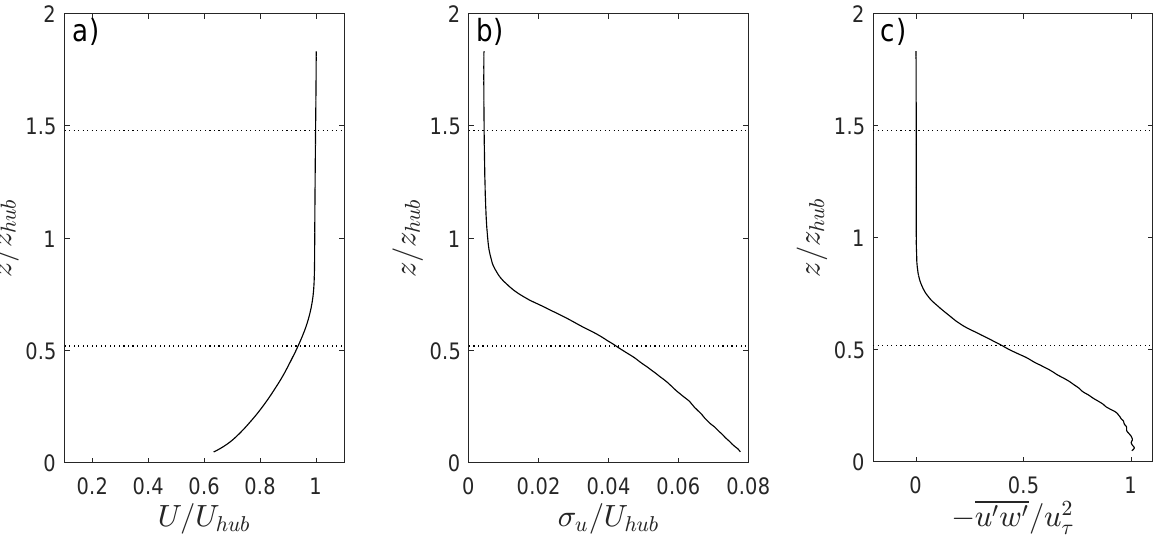
Figure 3. Non-dimensional characteristics of the incoming boundary layer. ( a ) mean velocity profile U/U ; ( b ) turbulence intensity σ hub Horizontal dashed lines indicate the bottom and top tips of the turbine.